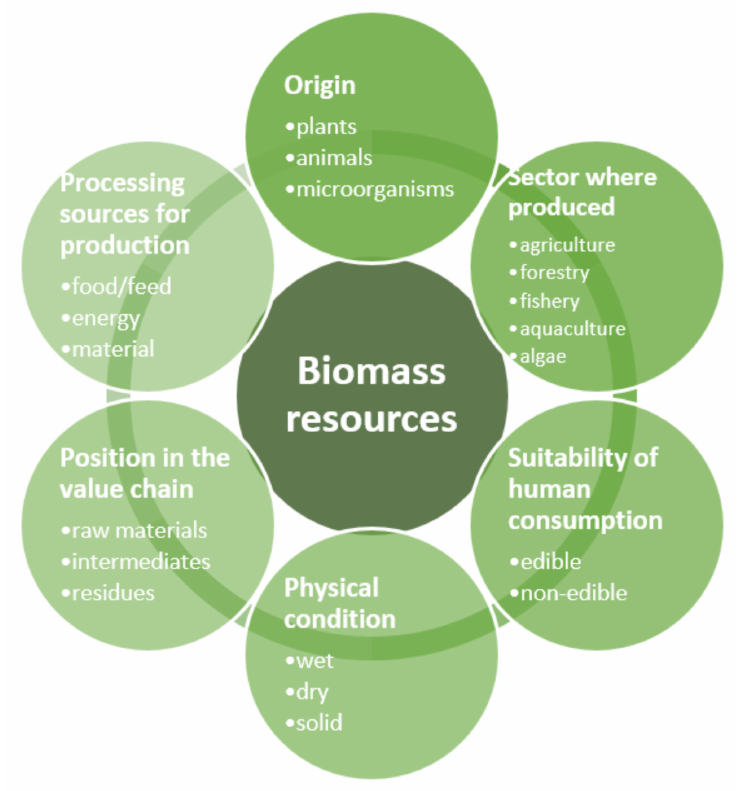
Figure 2. The classification of biomass resources